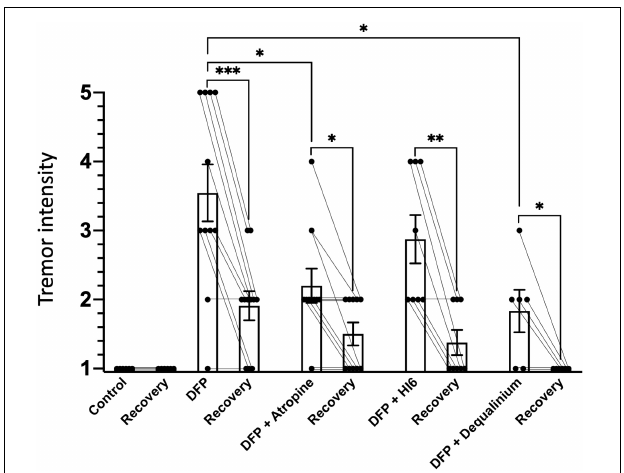
FIGURE 1 | Tremor intensity in response to diisopropylfluorophosphate (DFP) alone or DFP with treatments. Bars indicate average tremor intensity and standard error of means for 1 h immediately after injection (1st bar), and 22–24 h after injection (recovery, 2nd bar). The number of animals scored for each group were: control (saline), 6; DFP alone, 11; DFP with atropine, 10; DFP with HI6, 8; and DFP with dequalinium chloride, 6. Statistical significance was determined with one-way ANOVA between treatment groups, and paired t-test to compare acute tremors and recovery within a treatment group. Significance of p < 0.05, p < 0.01, p < 0.001 is indicated with single, double, and triple asterisks, respectively.